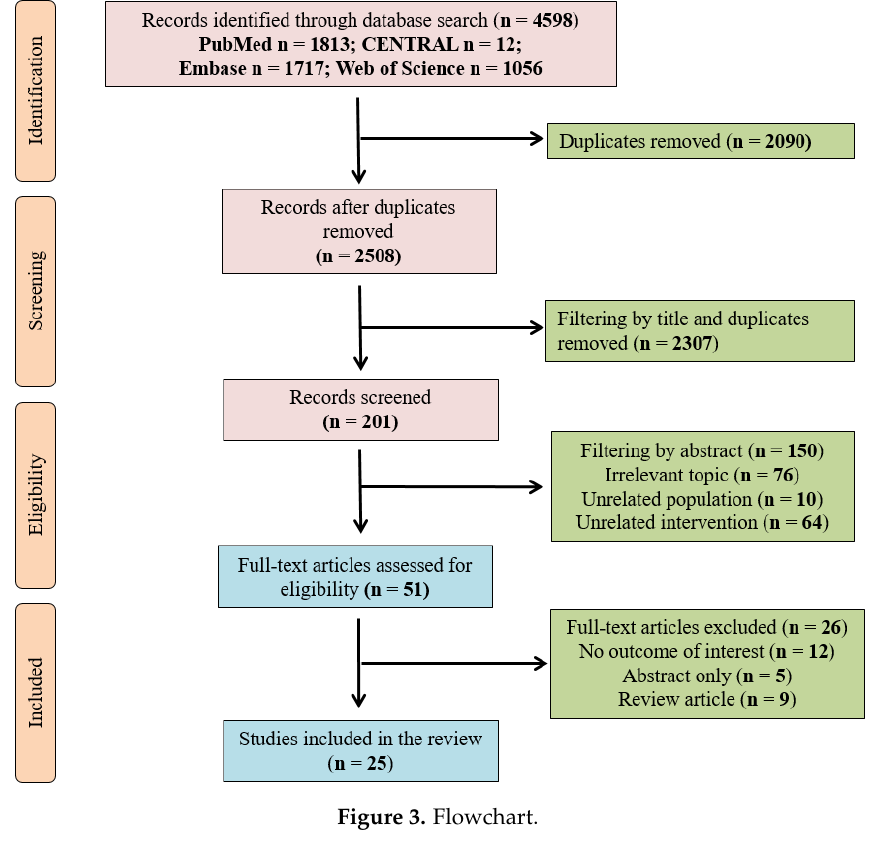
Figure 3. Flowchart. Table 2. Characteristics of included studies (RCR: respiratory control ratios; TAN: total adenine nucleotid; GDH: gluta- mate dehydrogenase; MDA: malondialdehyde; LDH: lactate dehydrogenase) Characteristic of Studies Outcome Parameters